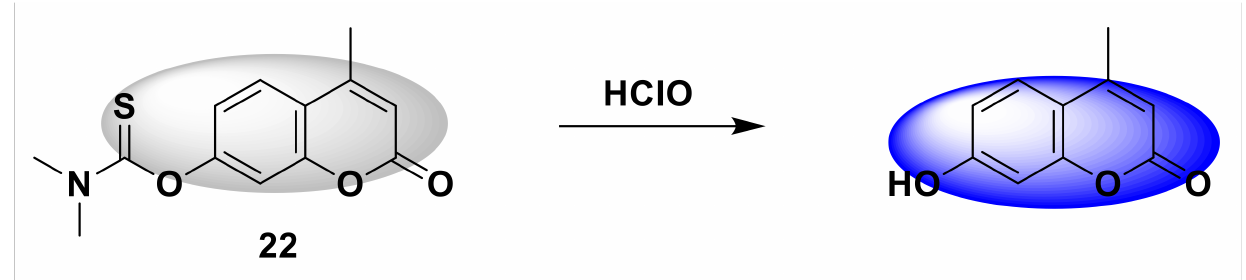
Figure 22. The reaction of probe 22 and